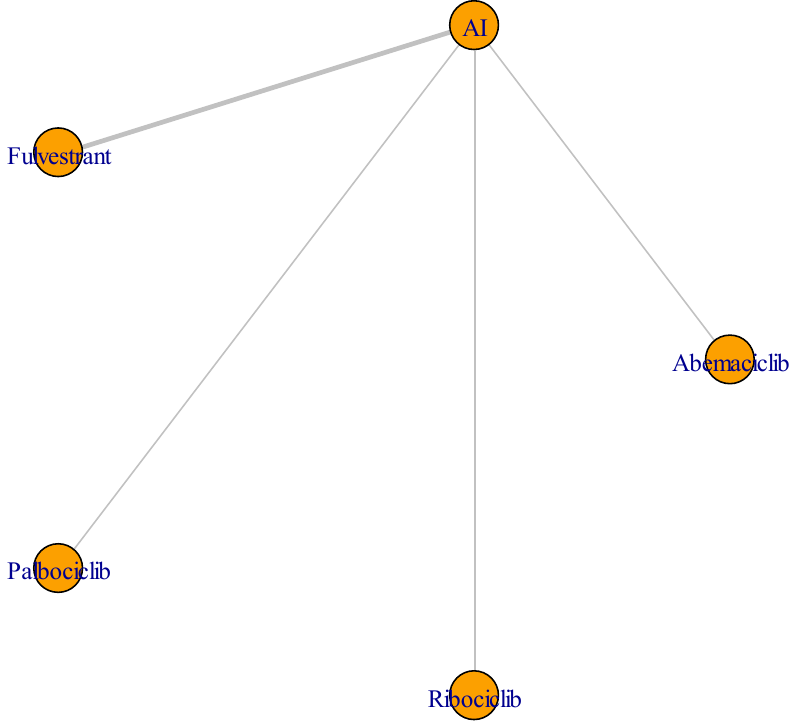
Figure 2. The network meta-analysis design: Network plot of the network meta-analysis. AI: Aromatase inhibitor.